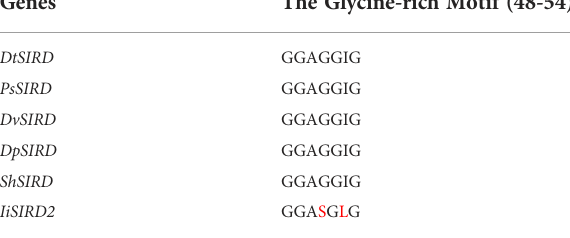
TABLE 1 Variations of the glycine-rich motif (Amino acid variations are marked in